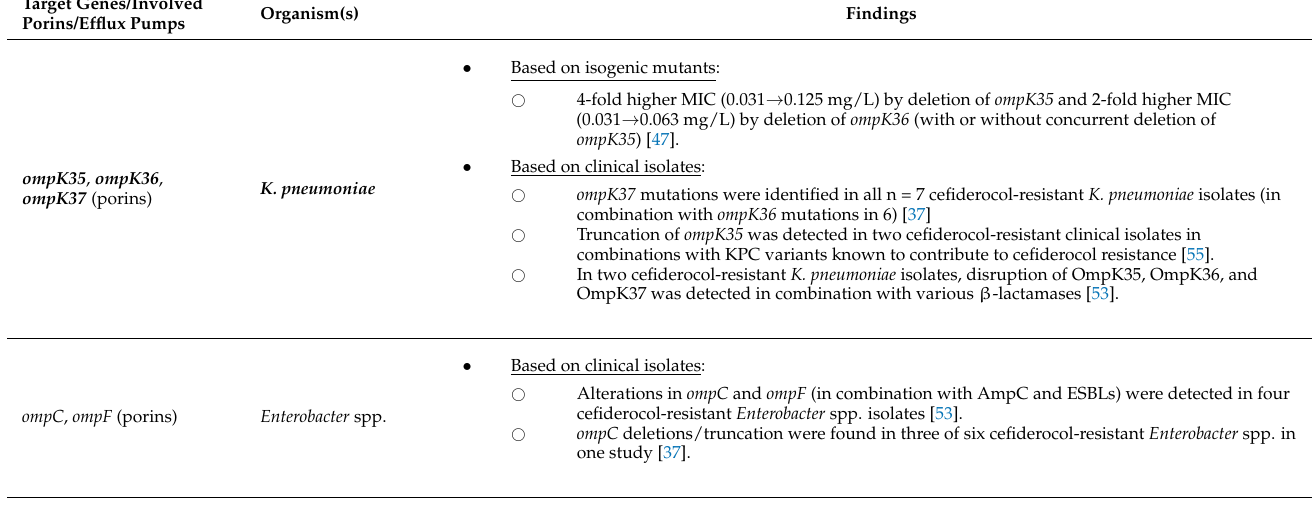
Table A3. Resistance mediated by mutations affecting function/expression of porins and efflux pumps.